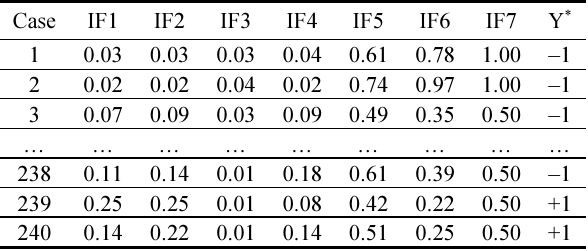
Table 3. Historical data for groutability